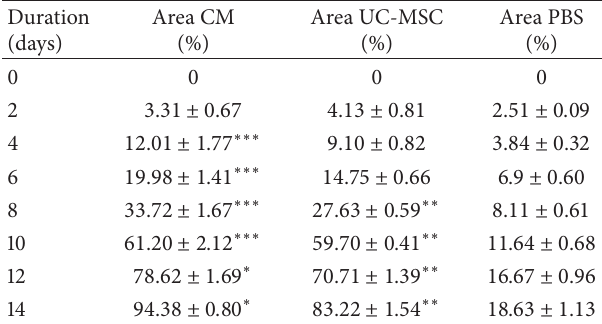
Table 3: Analysis of wound closure rate of all groups (mean ±